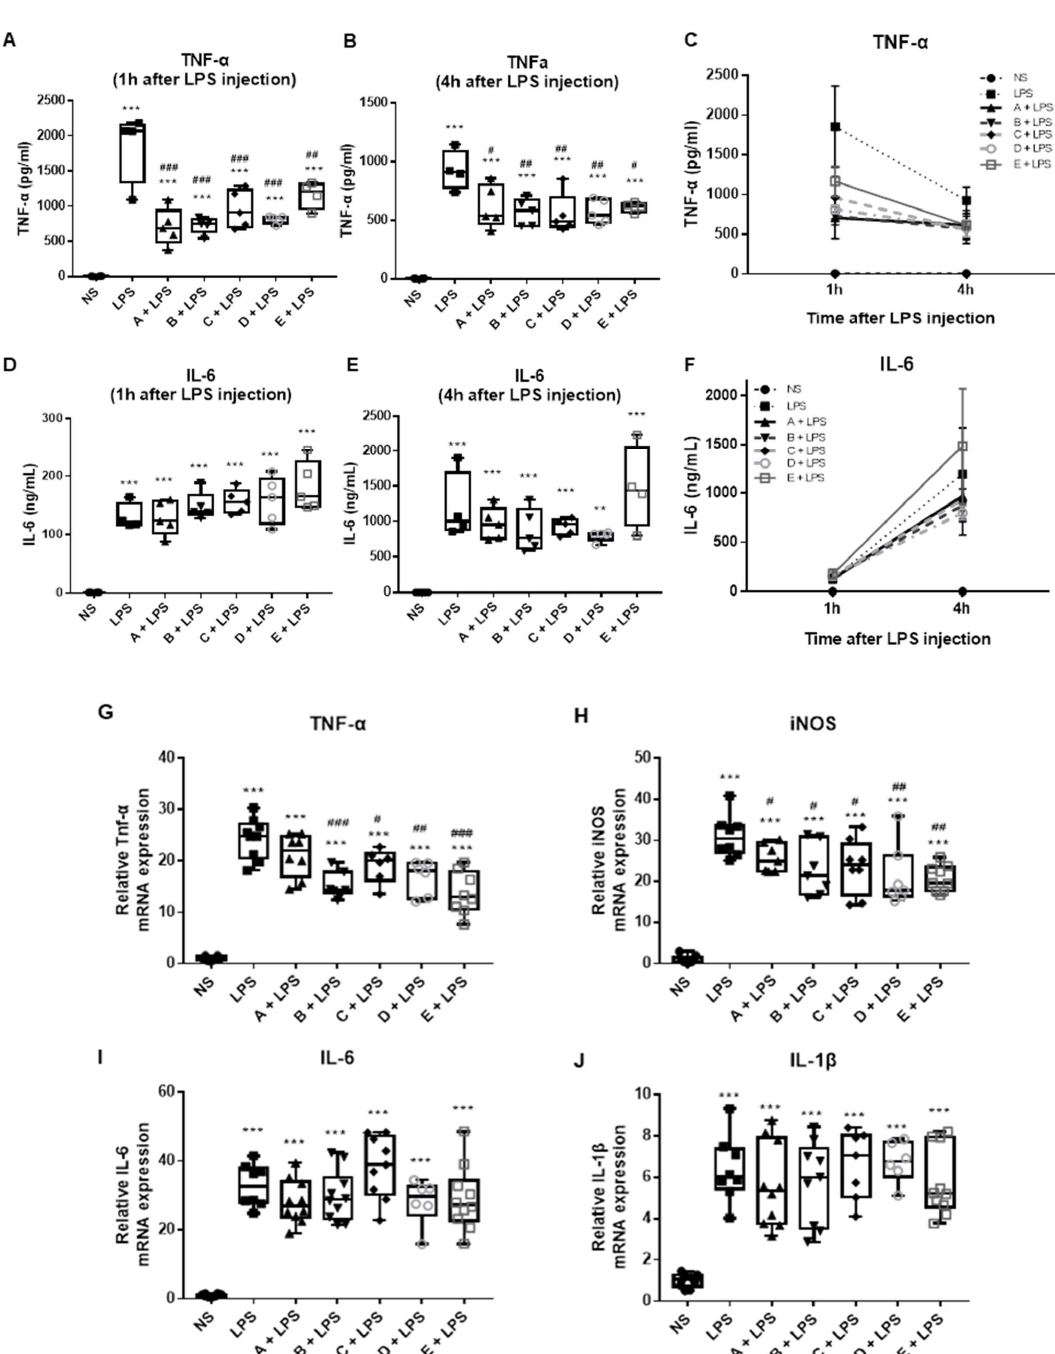
Figure 1. Greek honey types exert anti-inflammatory properties: serum ( A – C ) TNF-α and ( D – F ) IL-6 levels, measured 1 and 4 h after LPS injection. Liver mRNA expression of ( G ) TNF-α, ( H ) iNOS, ( I ) IL-6, and ( J ) IL-1β. All graphs represent measurements from 5 mice per group; the horizontal line in the box plots represents the median, and the whiskers represent the minimum and maximum. In the post-hoc test, the normal saline-treated group (NS) was selected as the control group for multiple comparisons with the LPS-injected groups: ** p < 0.01 and *** p < 0.001. The NS- vs. the LPS-injected groups or the LPS group was selected as the control group for multiple comparisons with the honey-treated groups: # p < 0.05, ## p < 0.01, and ### p < 0.005; the honey-treated group + LPS vs. the LPS control group. The absence of an asterisk or hash indicates no statistical significance. A: Epirus arbutus; B: Evros chestnut; C: Epirus fir; D: Crete fir; E: Manuka